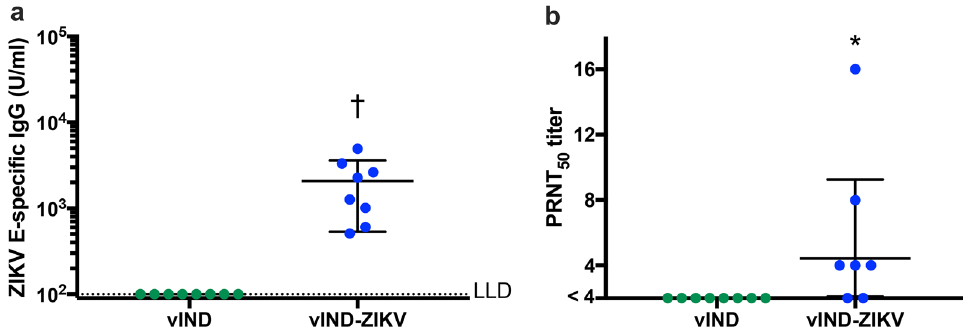
Figure 4. vIND-ZIKV vaccination induces E-specific IgG and neutralizing antibodies. Humoral immune responses in C57BL/6 mice (n = 8) vaccinated intramuscularly with 10 7 PFU vIND or vIND-ZIKV (D4W) are shown 4 weeks after vaccination. ( a ) ZIKV E-specific IgG titers were measured by ELISA at week 4. ( b ) Plaque reduction neutralization tests (PRNTs) were performed on serum collected from mice vaccinated with vIND or vIND-ZIKV. The PRNT 50 was calculated as the reciprocal of the dilution that resulted in at least 50% reduction in ZIKV plaques. Naïve sera (week 0) had PRNT 50 titers < 4 (data not shown). Asterisk represents statistical significance (*p < 0.01, † p < 0.001) with the Kolmogorov–Smirnov test. Horizontal lines represent geometric mean and error bars represent SD. LLD lower limit of